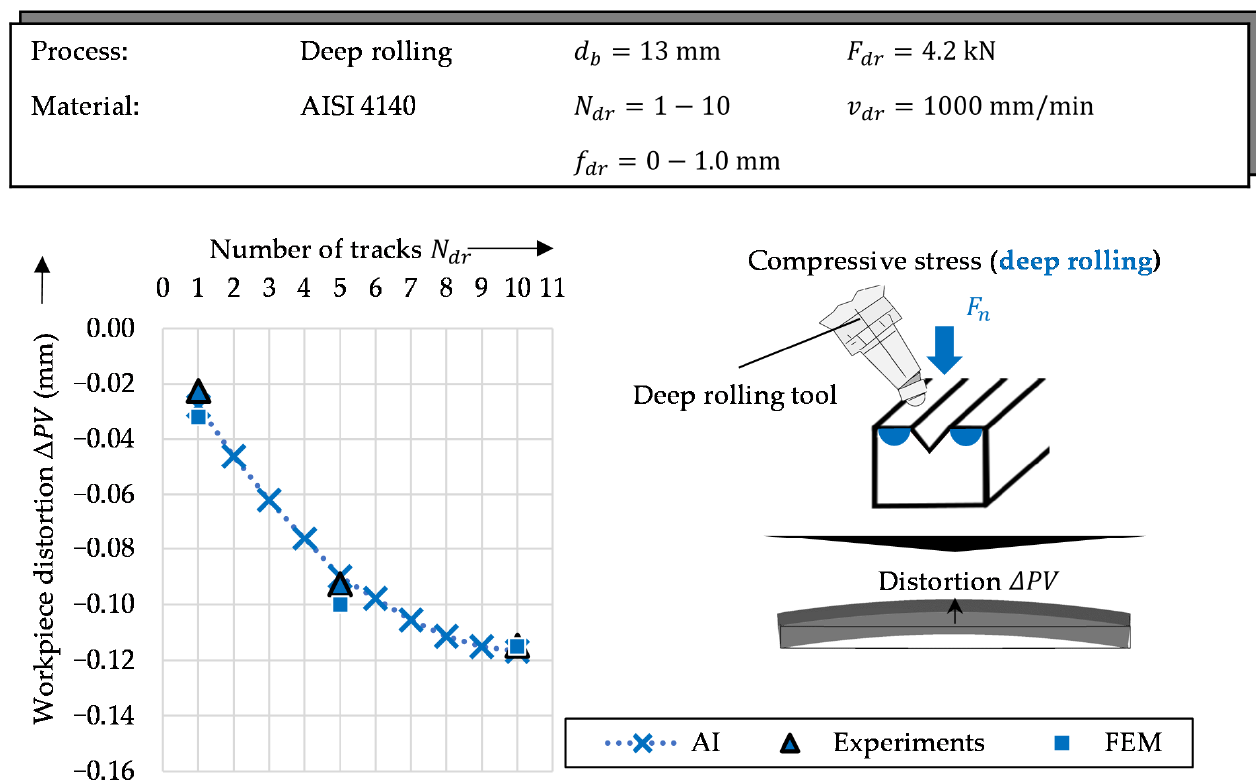
Figure 6. The workpiece distortion ∆ PV (peak-to-valley) values after multi-pass deep rolling for different numbers of tracks N dr : examples for experimental and numerical results (FEM) as well as distortions predicted by the AI regression model .